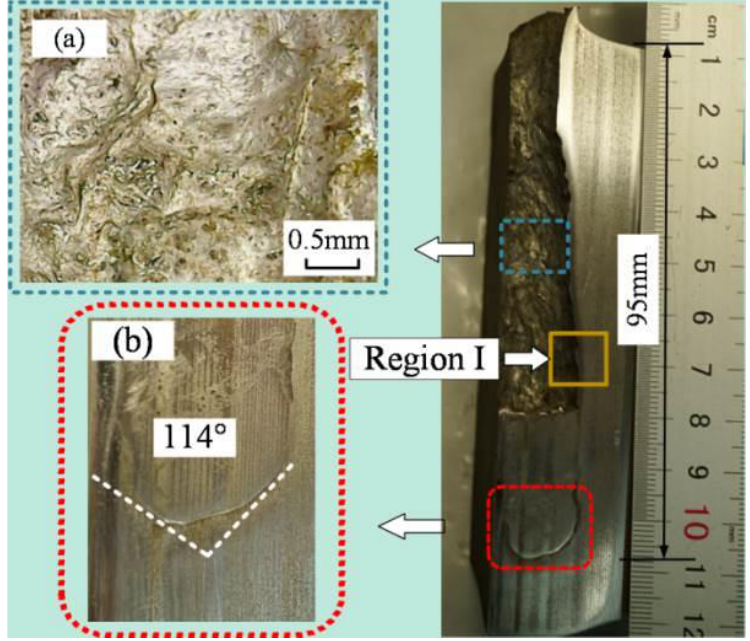
Figure 4. Longitudinal section of crater penetrated by the WHA rods. ( a ) partial enlarged dra- wing of craters; ( b ) head angles of the rods.